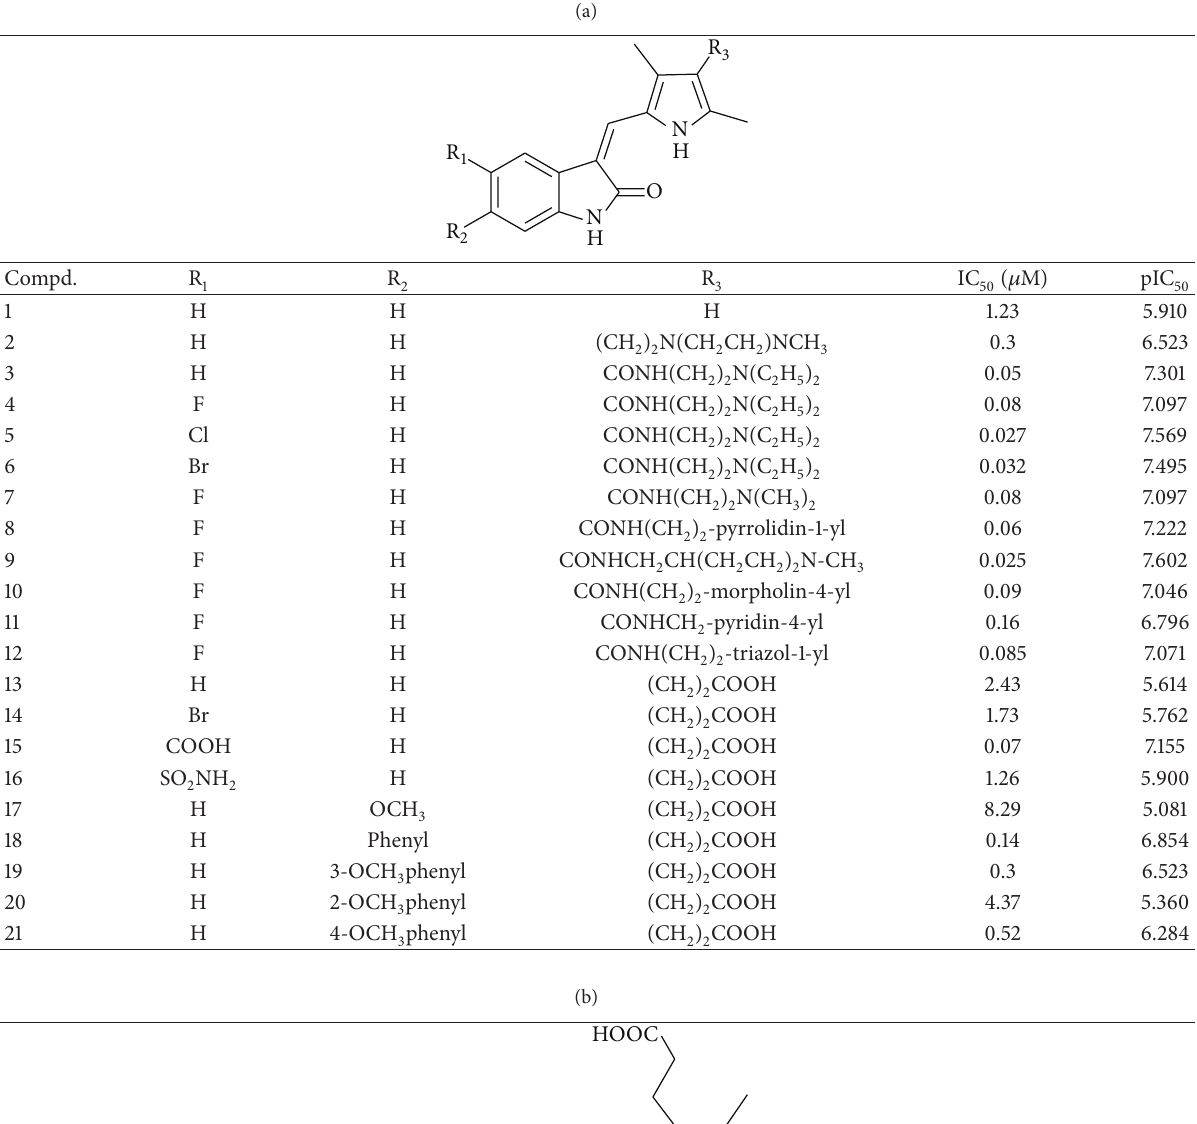
Table 1: Structures of 34 compounds and their VEGFR-2 inhibitory